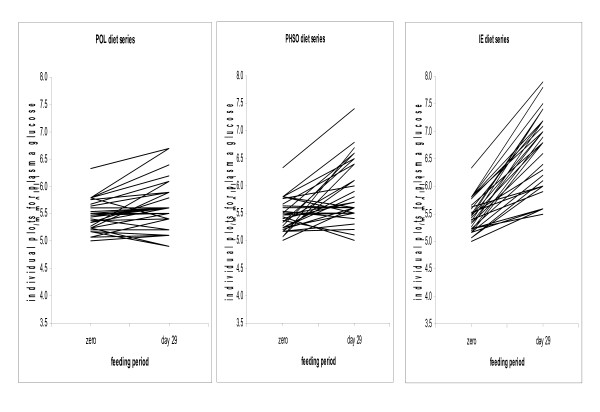
Individual fasting glucose values are depicted at entry and after 4 wk on each test fat. The rise was 3% for POL, 9% for PHSO, and 22% for IE.